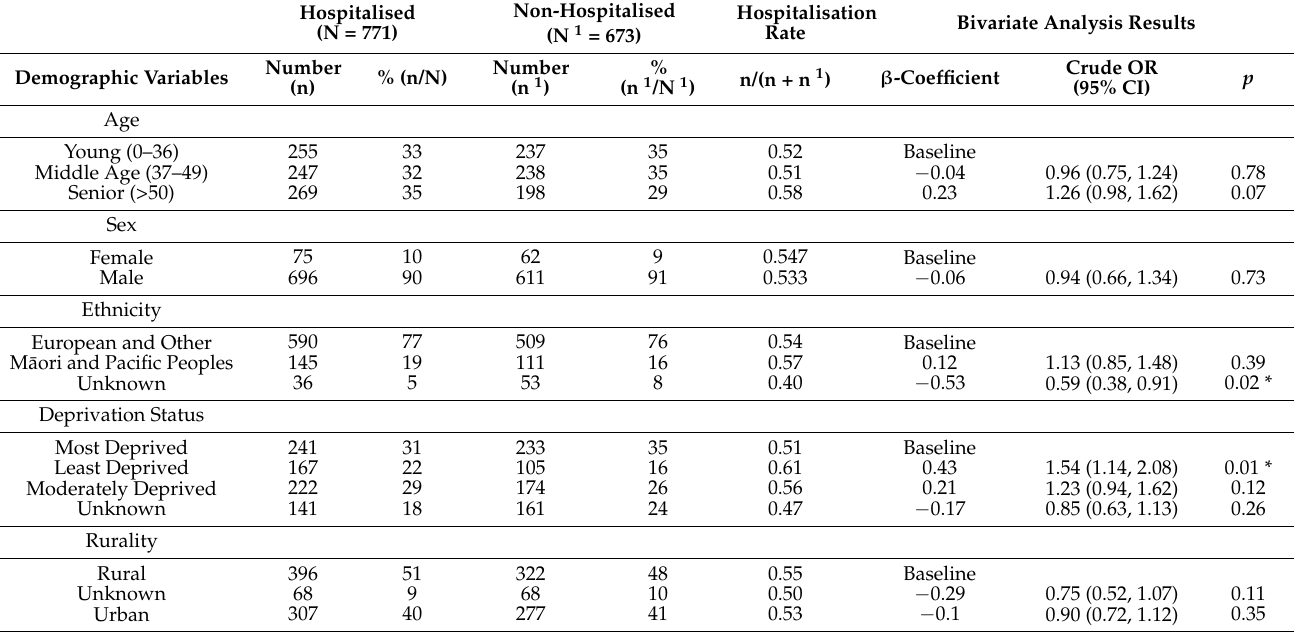
Figure 1. Alluvial diagram of counts of Occupation and Hospitalisation categories amongst notified cases of leptospirosis in New Zealand 1999–2017 by Serovar and Occupation categories represented as flows. Each black rectangle represents a category, its height proportional to its size. Correla- tions between categories are shown by curved ribbons whose width is proportional to group and correlation size. Table 1. Demographic variables and crude odds ratios for hospitalisation amongst notified cases of leptospirosis in New Zealand